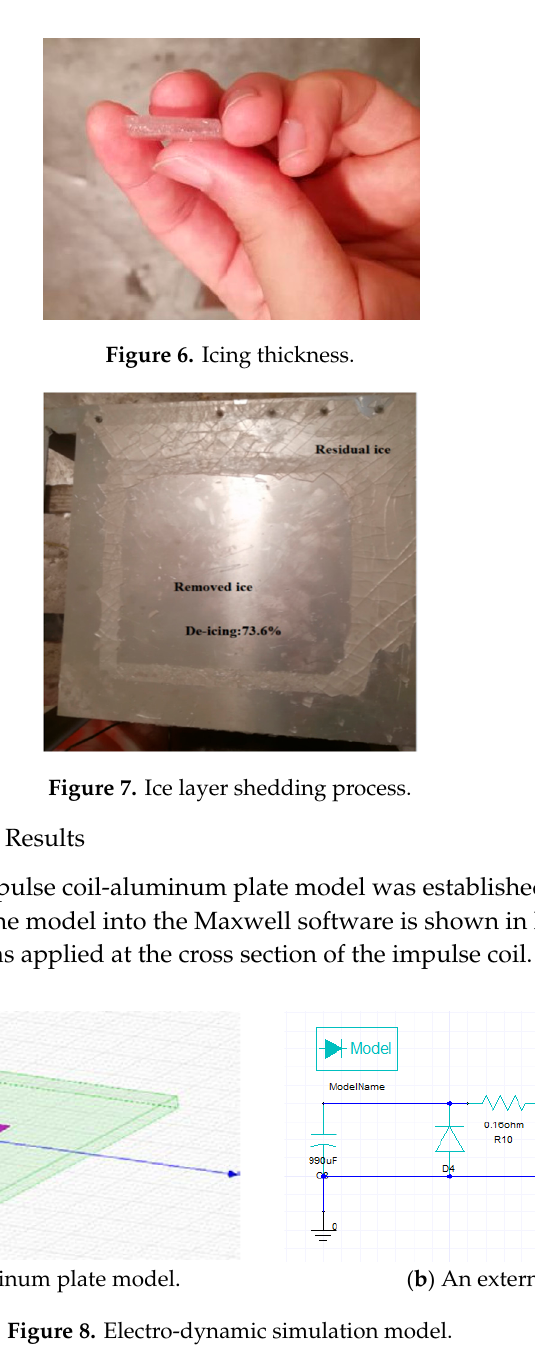
Figure 5. Icing results of the aluminum plate.